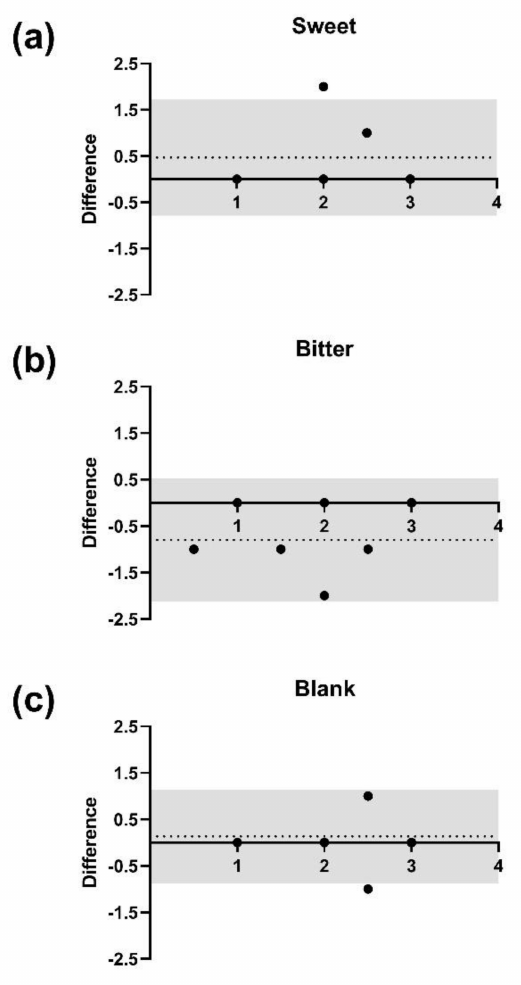
Figure 2. Bland–Altman plots for the reliability for the spatial discrimination task between two experimental sessions (n = 15). The vertical axis shows the differences in correctly identified piperine taste strips (PTS) between the first and second sessions. The horizontal axis shows the average number of correctly identified PTS between both sessions for each stimulus separately. The 95% limits of agreement are indicated within the grey area, the horizontal dotted line indicates the bias (mean difference). ( a ) Sweet taste strips compared to PTS. ( b ) Bitter taste strips compared to PTS. ( c ) Blank taste strips compared to